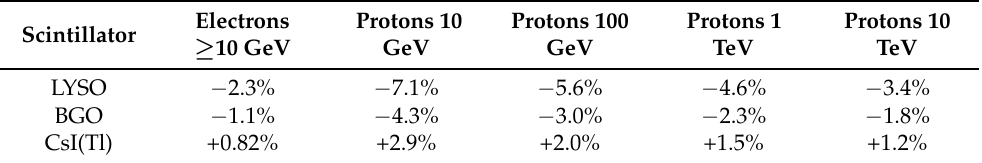
Table 4. Energy shift due to the nonproportionality of light yield for a 1 m 3 homogeneous calorimeter produced with different scintillating materials